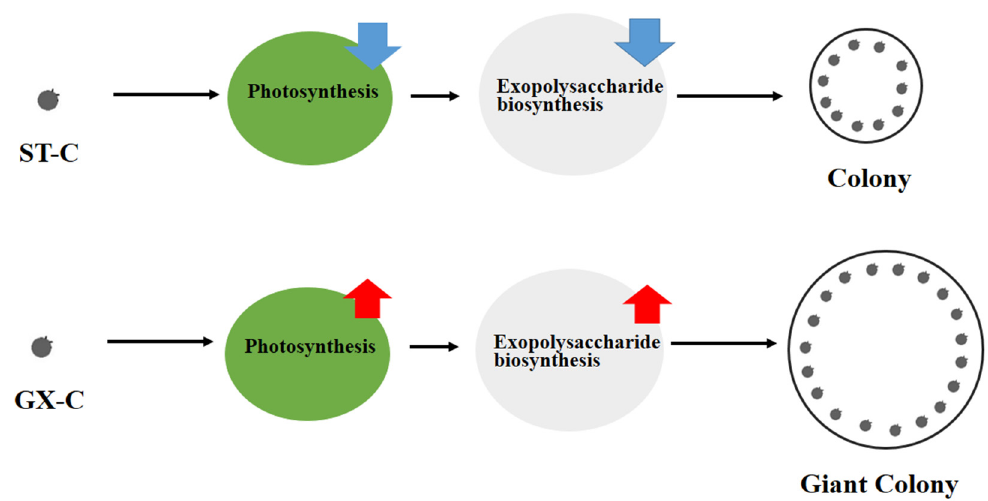
Figure 7. Possible working model for the colony formation in two P. globosa strains. ST-C represents the lab colonial cells of P. globosa originally collected in Shantou and GX-C represents the lab colonial cells of P. globosa originally collected in Guangxi; the red arrow means upregulation of metabolic process and the blue represents down regulation of metabolic process.